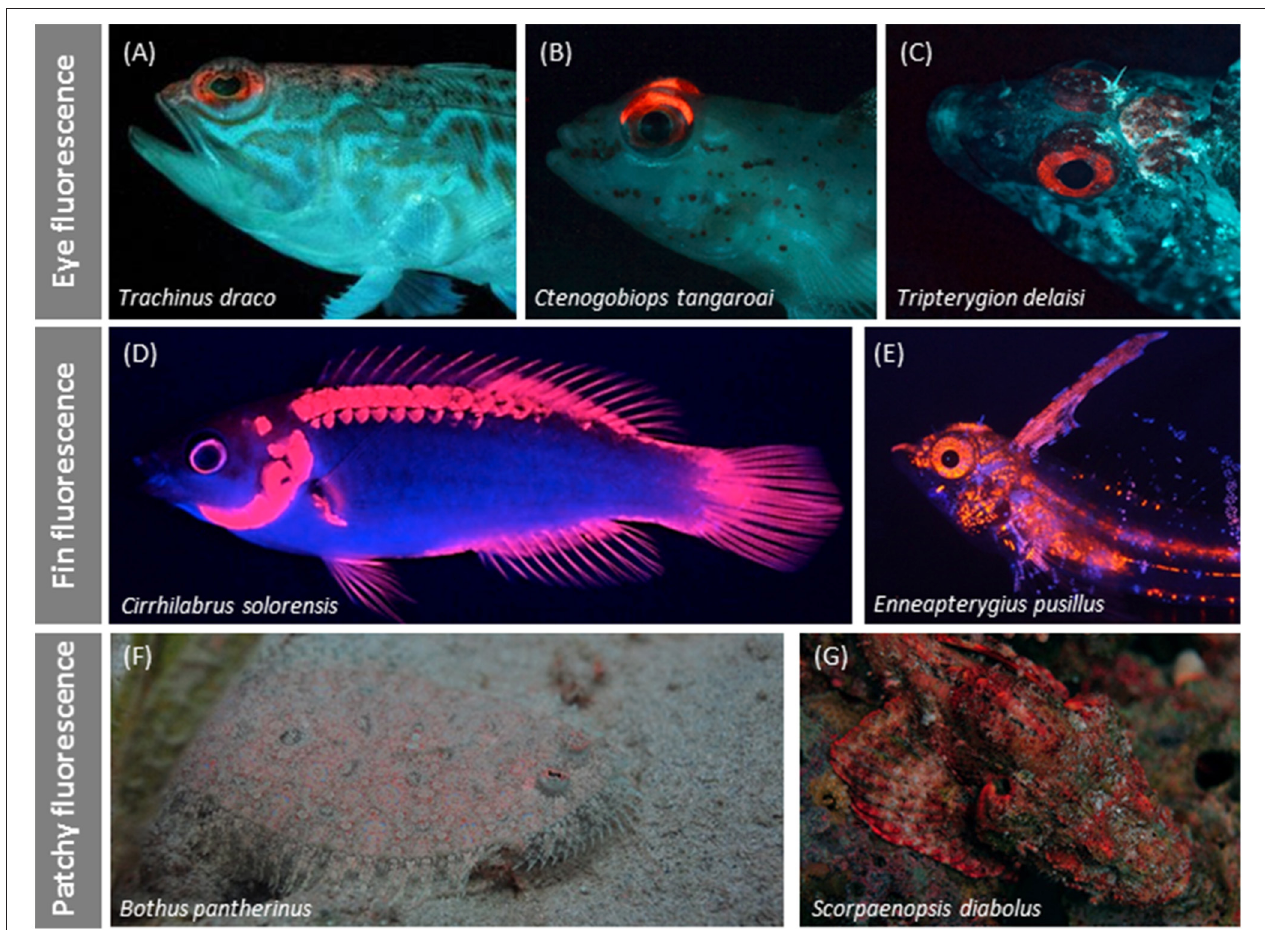
FIGURE 8 | Variation in red fluorescent body patterns. Irides are often the only or clearly most prominent fluorescent structures as in some weevers (A) , gobies (B) , and triplefins (C) . Fin fluorescence may suggest a signaling function as in a fairy wrasse ( Gerlach et al., 2014) (D) or triplefin (E) . Patchy fluorescence characterizes the irregular distribution of red fluorescence over the body as shown by this flatfish (F) and scorpionfish (G)